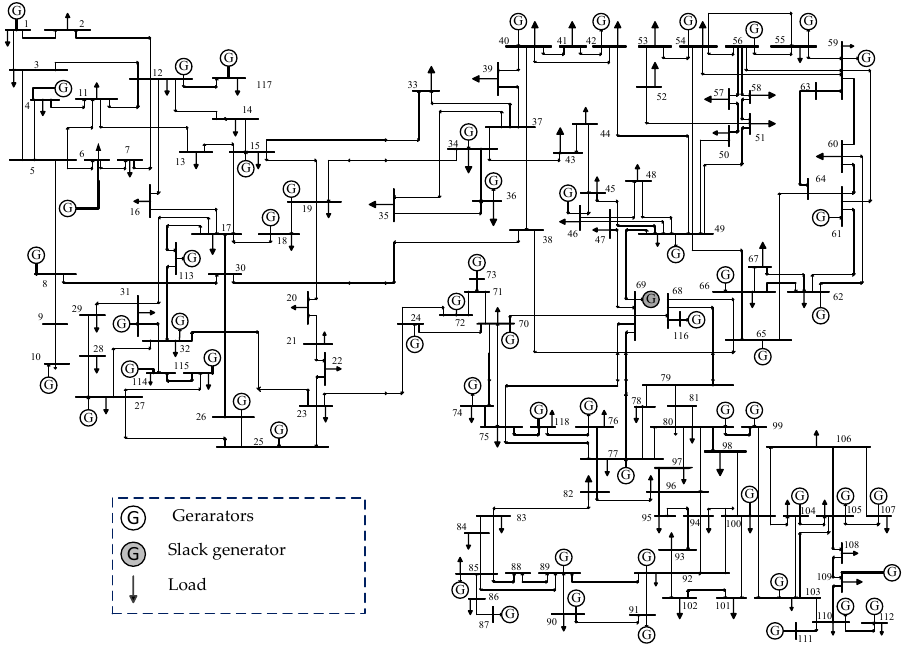
Figure 4. The IEEE 118-bus test system. Table 1. The capacitor parameters of the IEEE 118-bus test